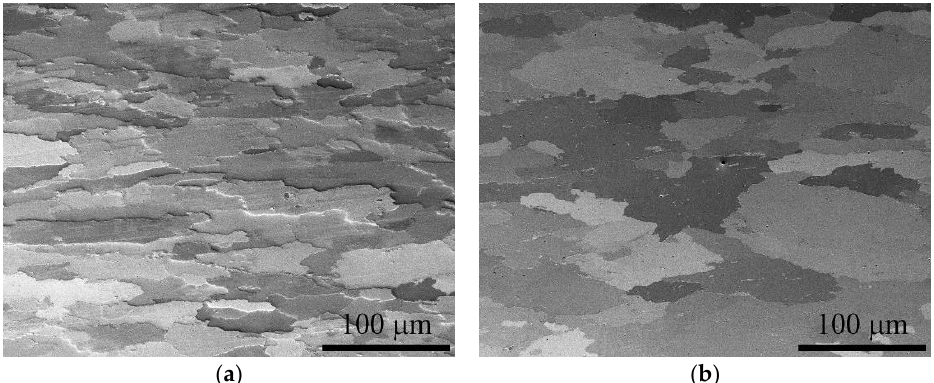
Figure 6. Completely recrystallized grain structure in ( a ) Fe-11Al-1O and ( b ) Fe-17Cr-7Al-4Y 2 O 3 systems after annealing at 1200 °C for 0.5 h.